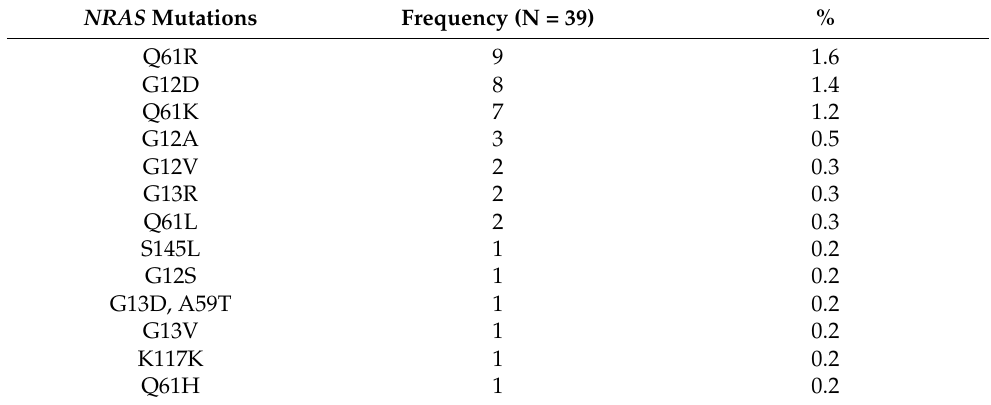
Table 5. N RAS mutations. Table 5. NRAS mutations.